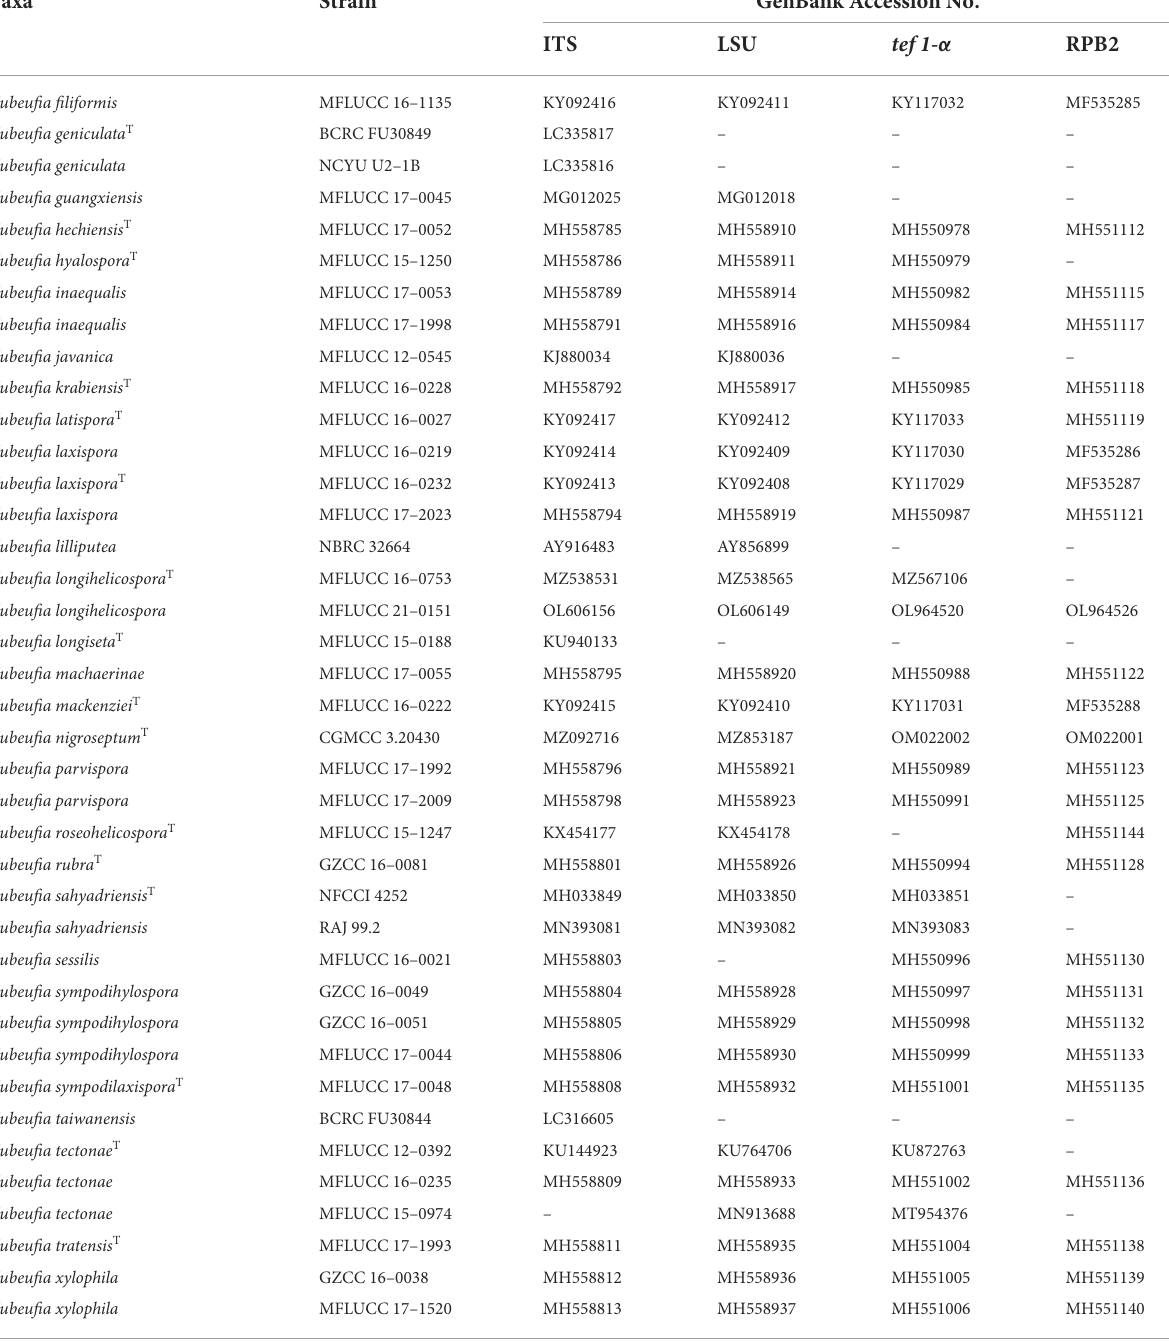
Figure 1. Alignment exhibits 1,618 distinct alignment patterns; the proportion of gaps and completely undetermined